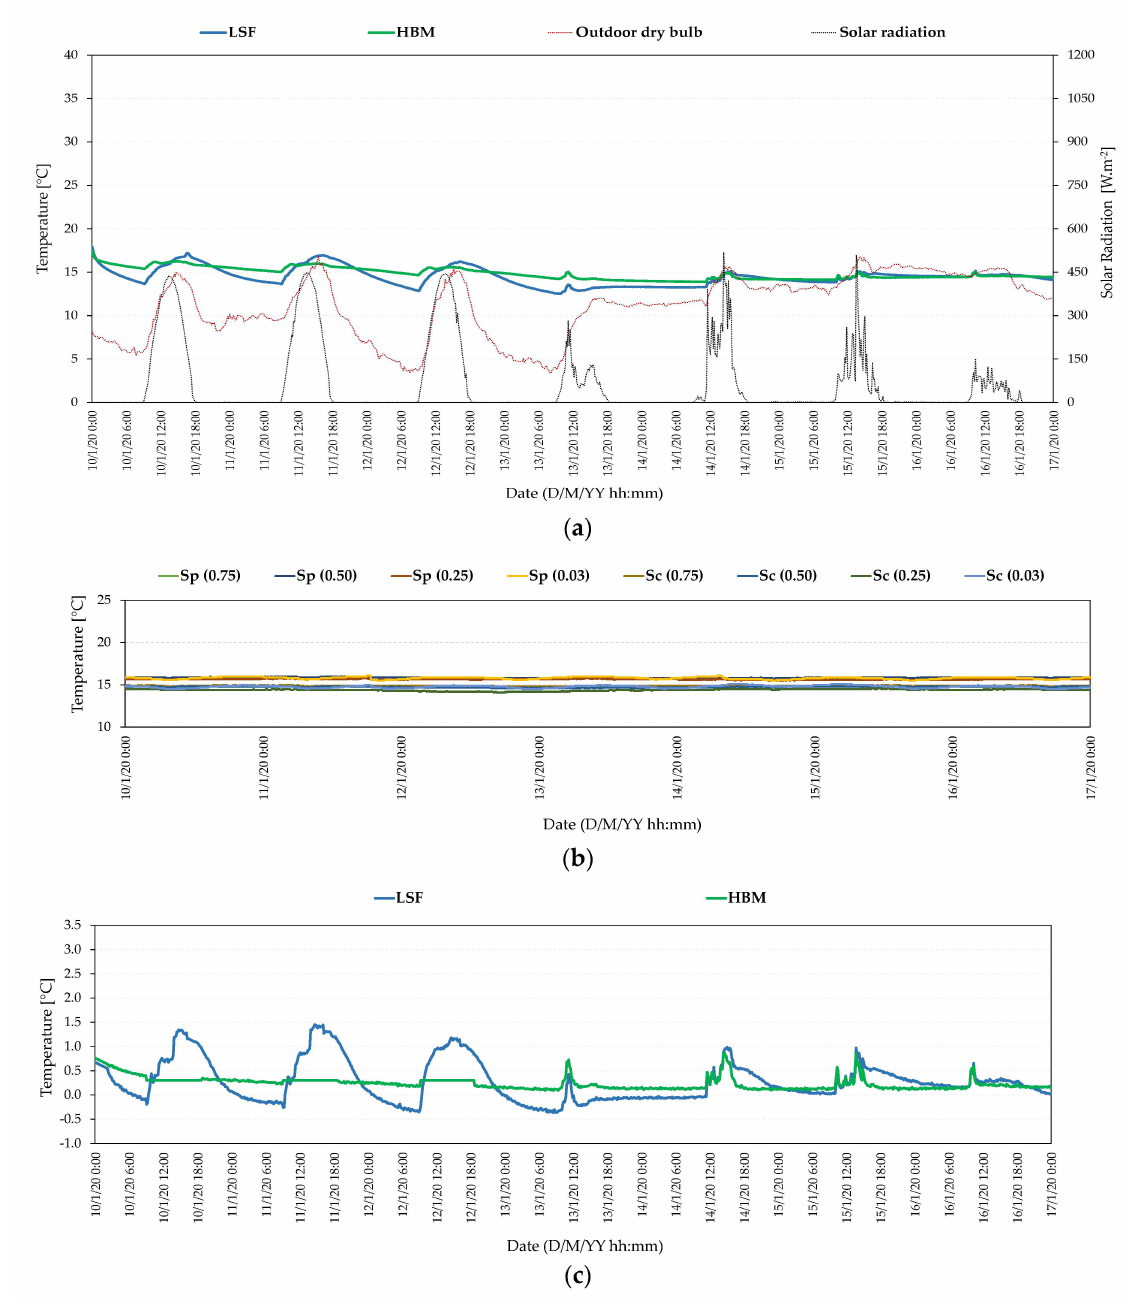
Figure 7. Winter week analysis: ( a ) indoor air temperatures in the experimental test cells and outdoor environmental conditions; ( b ) soil temperatures at different depths and locations; ( c ) indoor air temperature vertical stratification between the inferior and superior monitoring